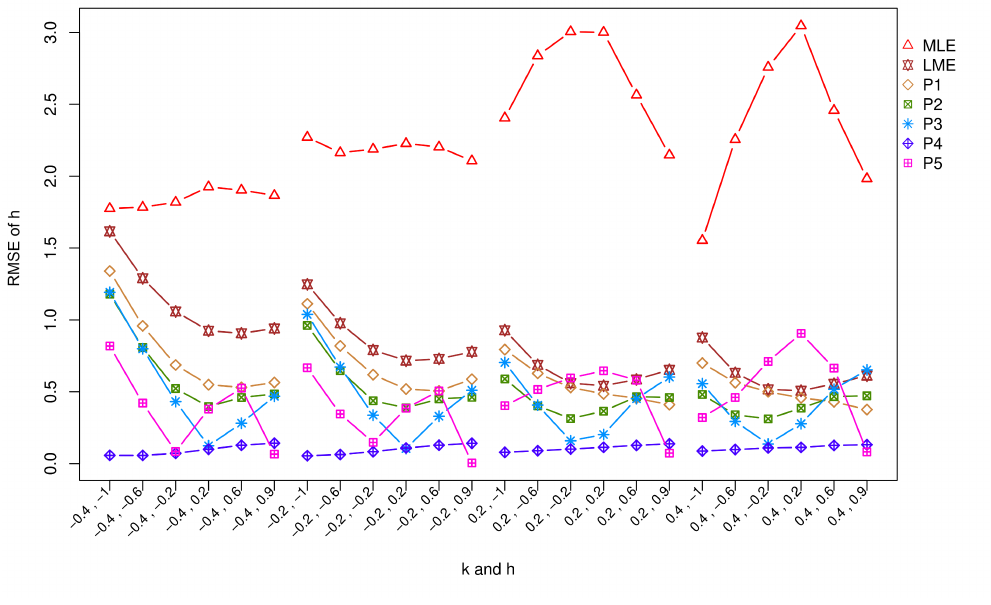
Figure 4. Same as Figure 3, but for parameter h